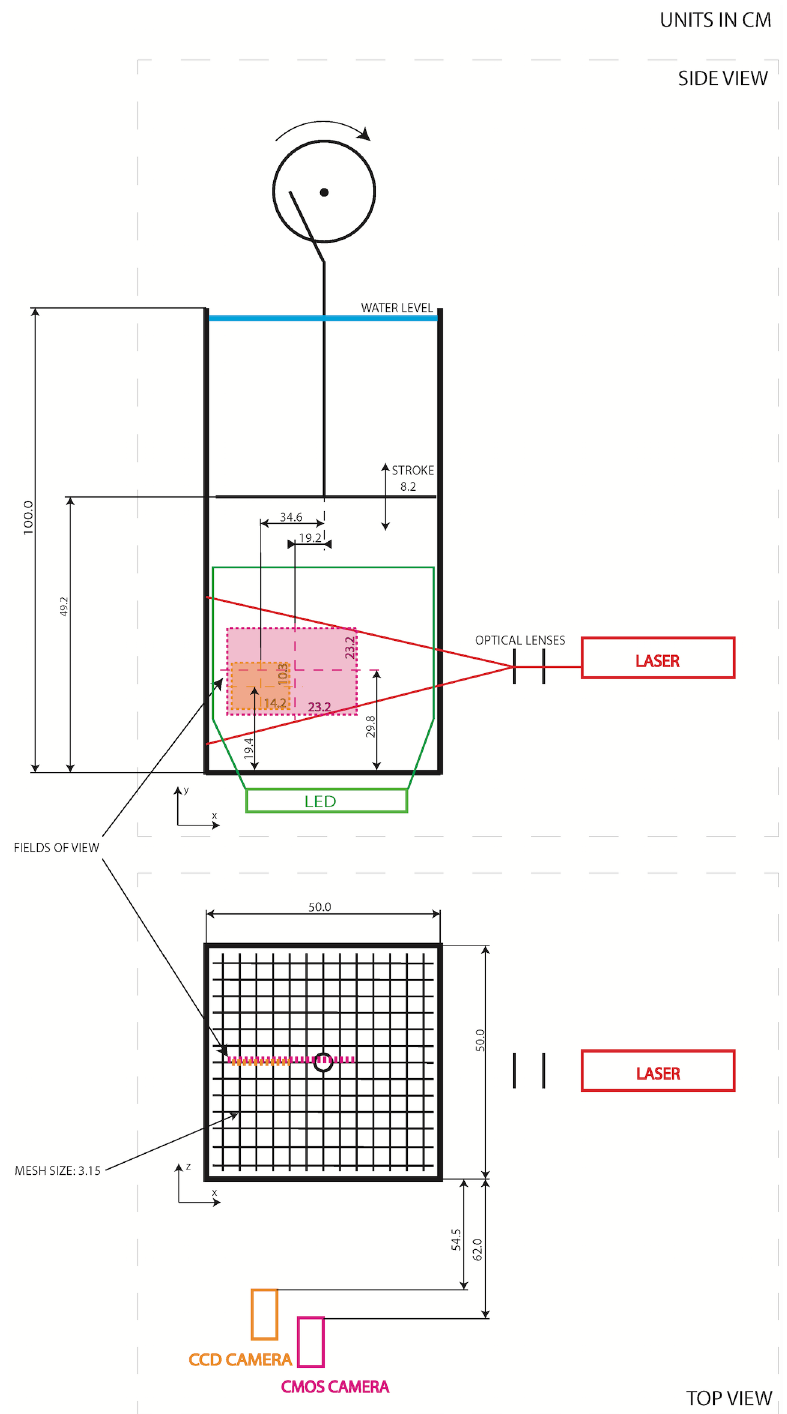
Fig 1. Schematic description of the experimental setup, which consists of a grid turbulence tank, particle image velocimetry setup, and 2D particle tracking setup. Dimensions on the schematic are provided in